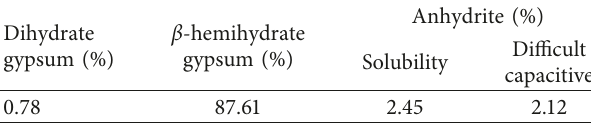
Table 1: Gypsum compositions of phosphogypsum.